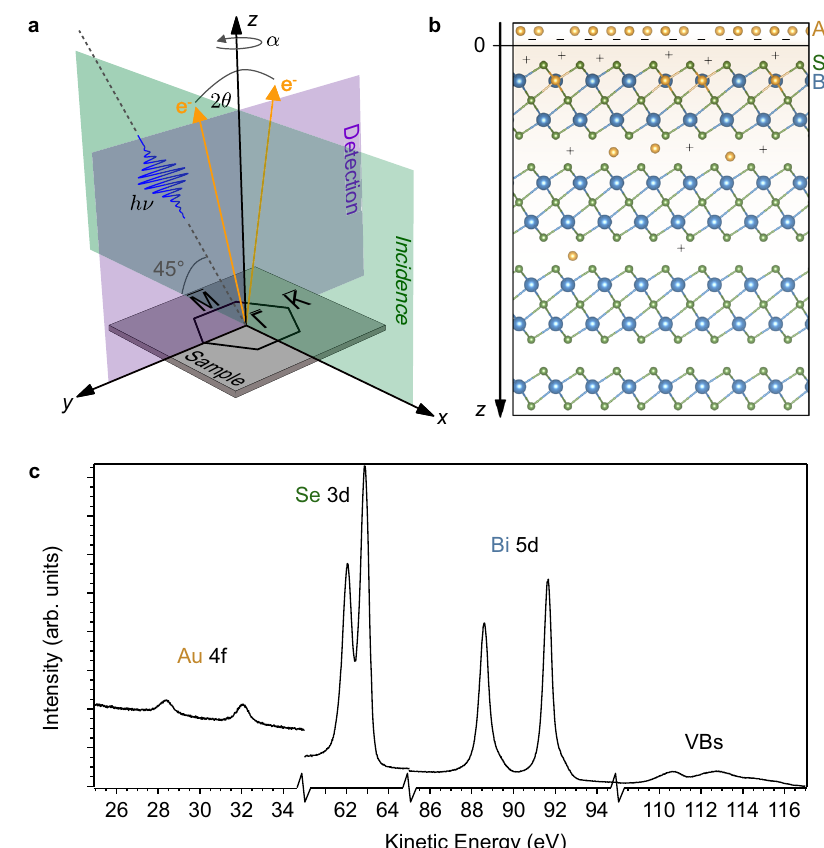
Fig. 1 Experimental geometry and effects of surface Au deposition. a Experimental geometry of the photoemisison experiment. α and θ are the azimuthal and emission (parallel to the analyser slit) angles respectively. b Illustration of the Bi 2 Se 3 system following Au deposition, as viewed along the a- axis. The sample is cleaved perpendicular to the c- axis. c Wide-energy range angle-integrated spectrum of Bi 2 Se 3 following 1 ML Au deposition. The incident photon energy was h ν = 120 eV. Core level states and valence bands (VBs) are